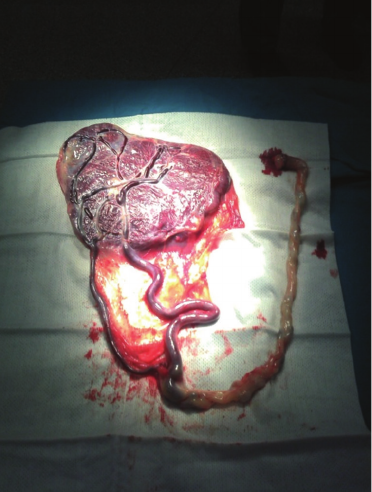
Figure 2: Photograph showing velamentous cord insertion of the